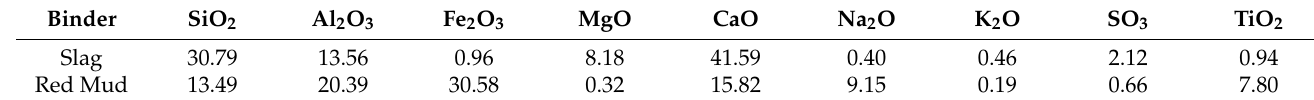
Table 1. Chemical compositions of slag and red mud (wt. %).